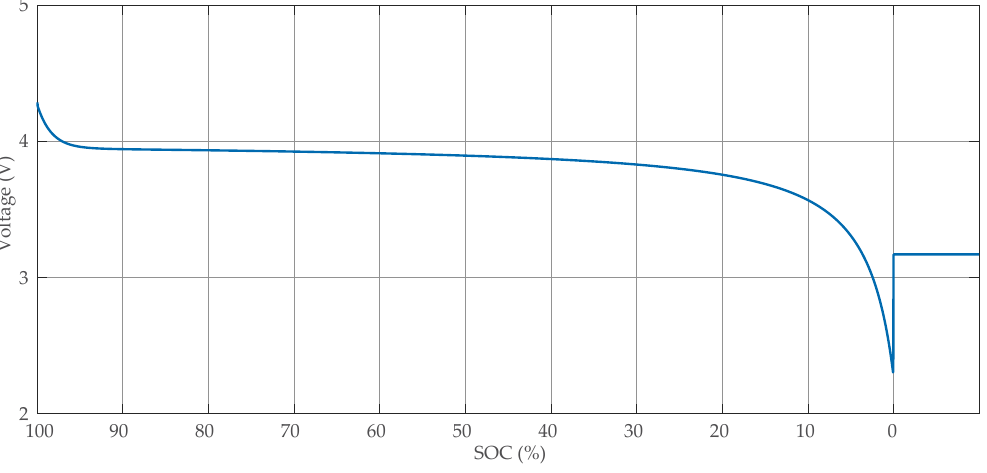
Figure 13. V oc approximation according to the SOC for a Li-Po